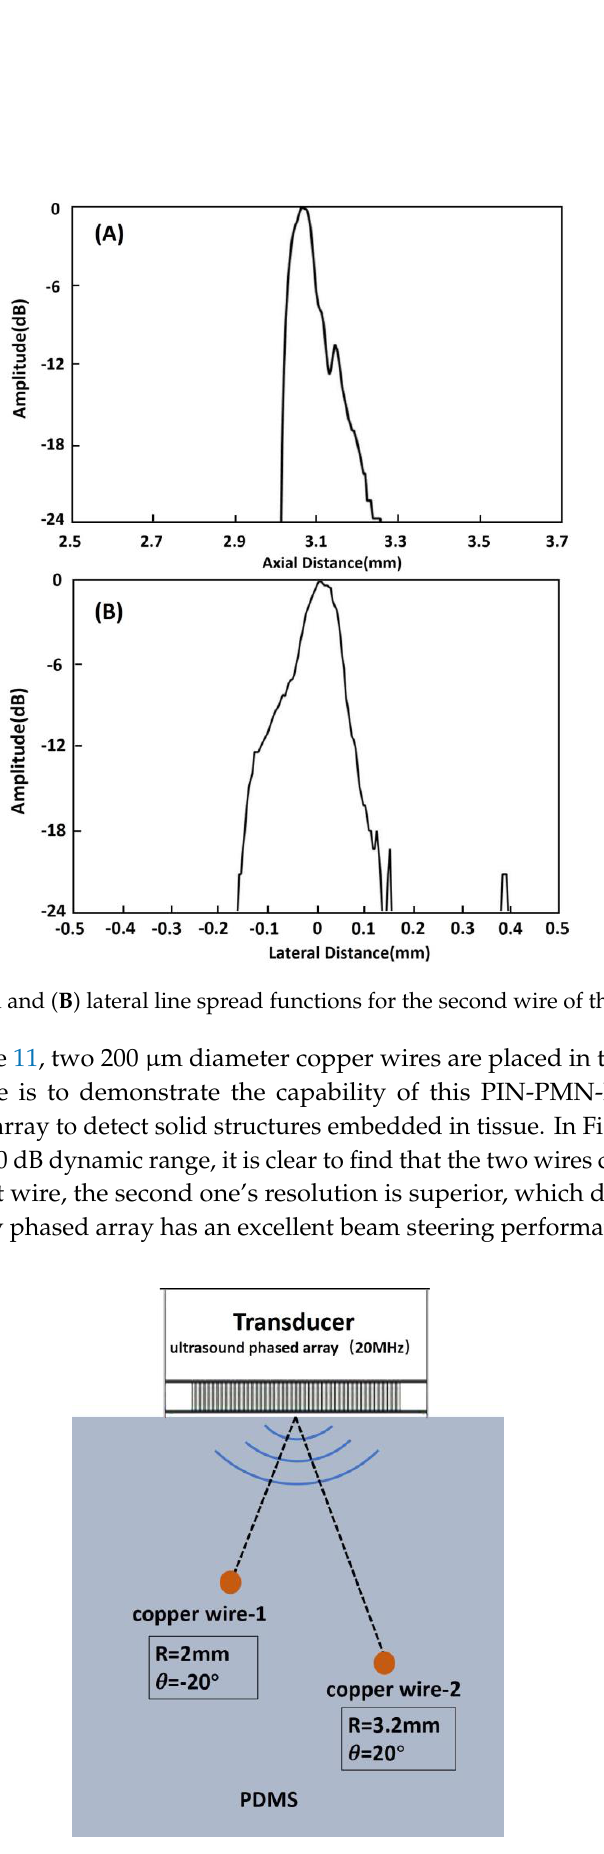
Figure 12. ( A ) Copper wires phantom image. ( B ) Pseudo-color image of copper wires phantom. 4. Conclusions